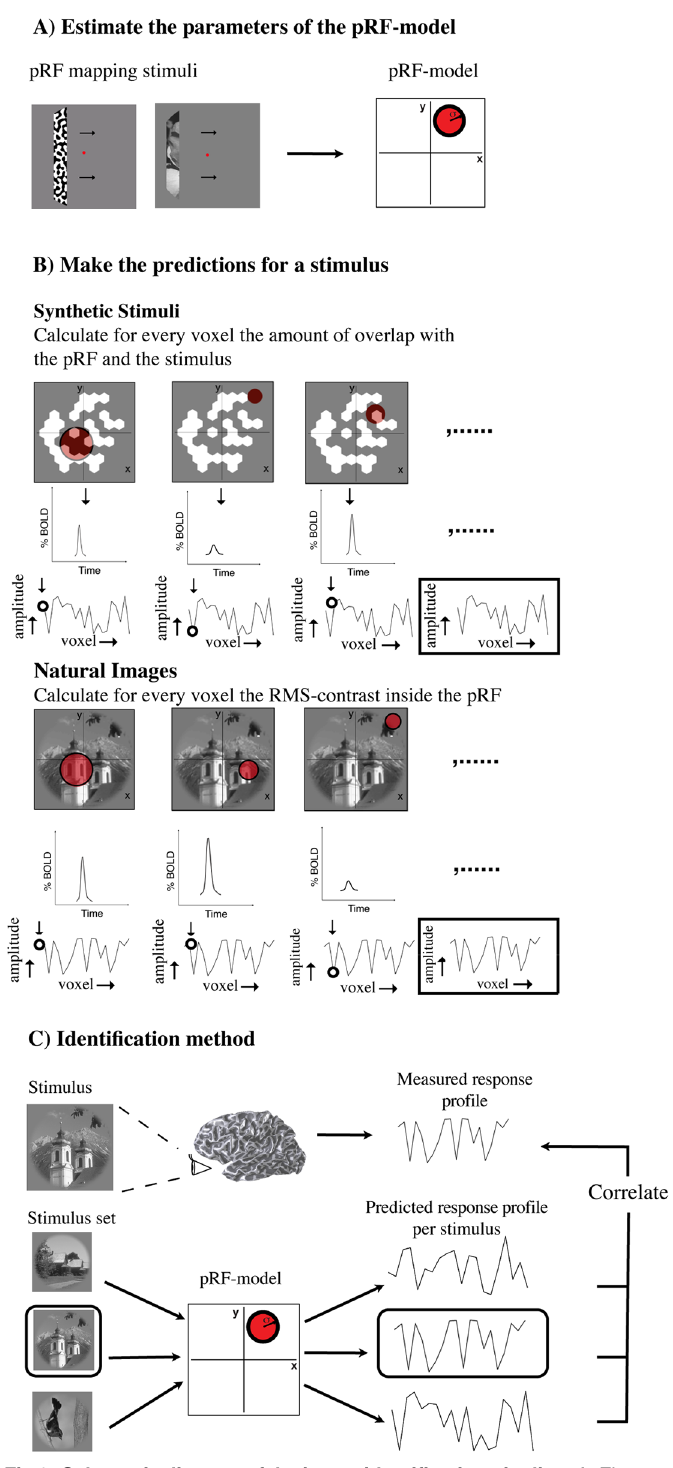
Fig 3. Schematic diagram of the image identification pipeline. A: First, we estimated the parameters of the pRF for every voxel based on the pRF bar stimuli. The pRF is modeledas a circularsymmetric Gaussian function of which we use the parameters for positionand size. B: Second, we predictedthe responseprofiles for a large set of candidateimages by either summing the overlap of the stimulus with each voxel’s pRF (for the synthetic images), or by calculatingthe RMS-contrast inside each voxel’s pRF (for the natural images). C: